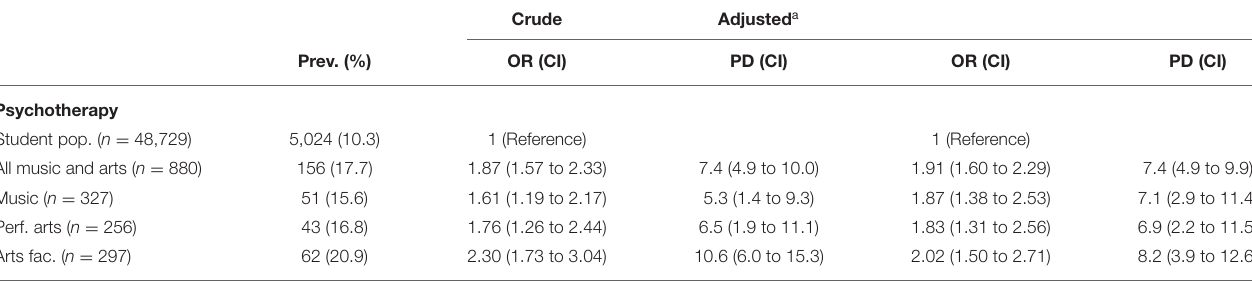
TABLE 4 | Logistic regression analysis of use of psychotherapy (psychologist and/or psychiatrist) in Norwegian music and arts students compared to the general student population. Crude Adjusted